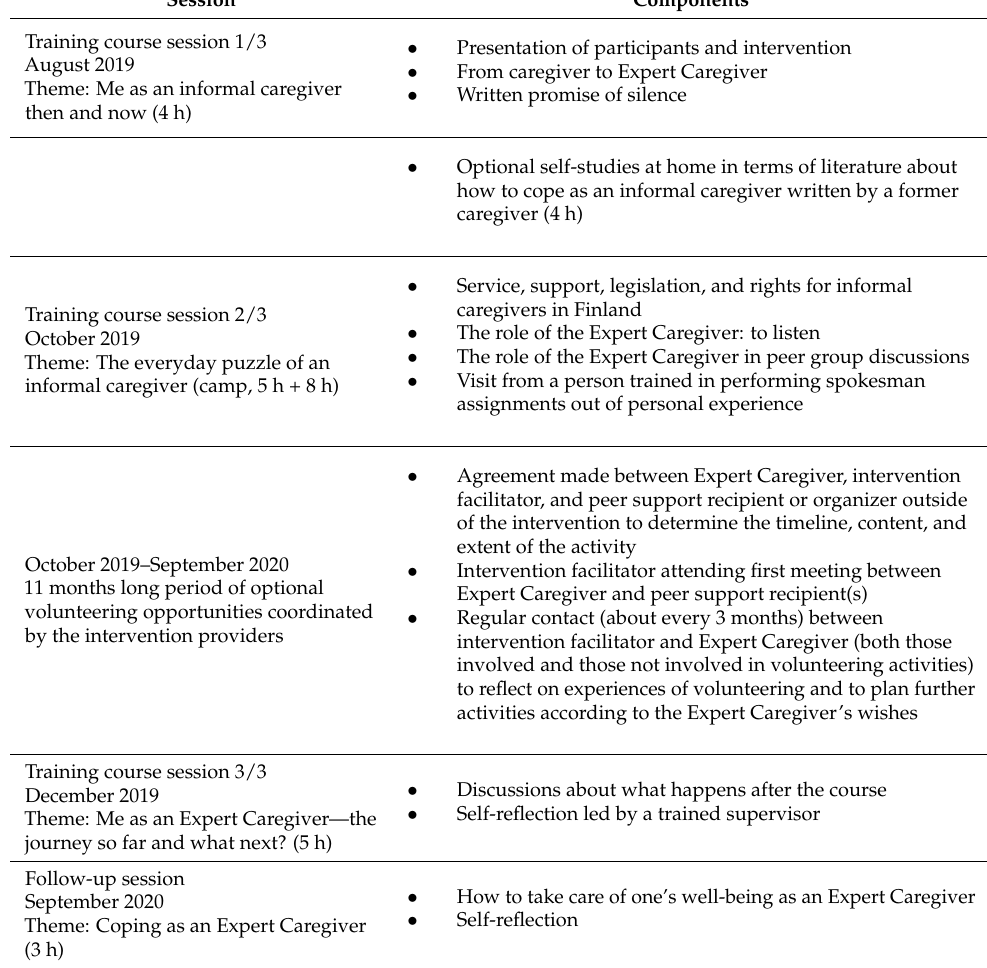
Table 1. The intervention content and